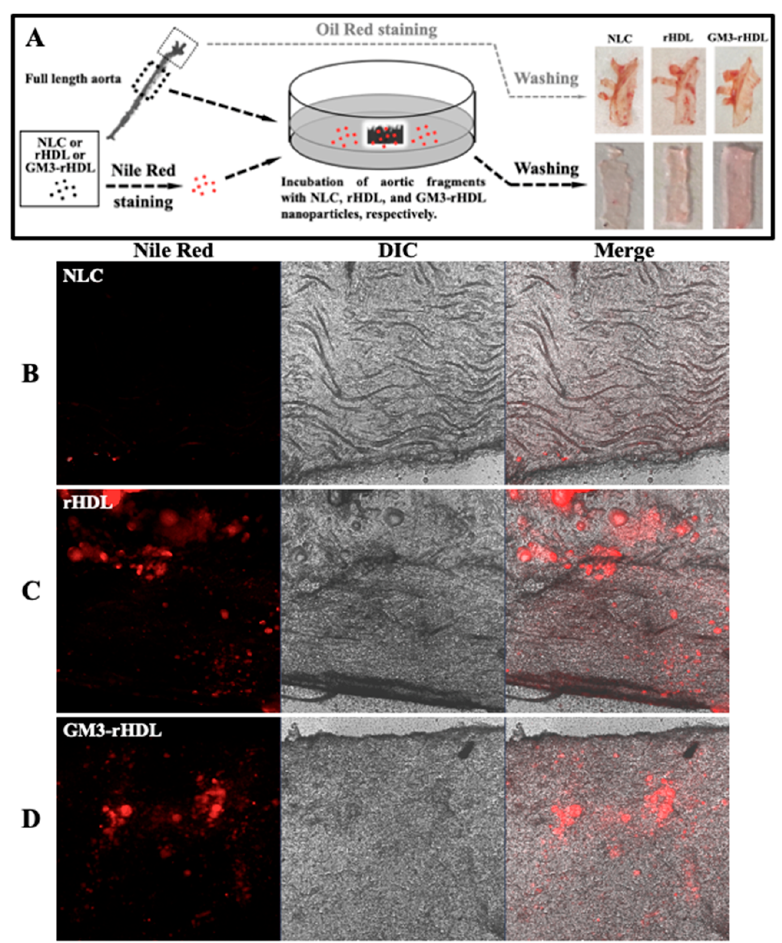
Figure 8. In vitro validation of atherosclerotic plaque-targeting ability of rHDL and GM3-rHDL nanoparticles. ( A ) Schematic diagram showing the experimental process. One fragment of an aorta is stained with Oil Red in order to confirm the formation of atherosclerotic plaques; a nearby fragment of the same aorta is incubated with an indicated nanoparticle pre-stained with Nile Red for determining the plaque-targeting ability of nanoparticles. The right panel shows the images of the entire fragments. ( B – D ) Representative confocal microscopic images of local areas of the aortic fragments incubated with NLC ( B ), rHDL ( C ), and GM3-rHDL ( D ), respectively, which were pre-stained with a fluorescent dye for lipids (Nile Red). The aortas were from the ApoE − / − mice fed a high fat diet. Panels from left to right: fluorescent, DIC, and merged images, respectively.